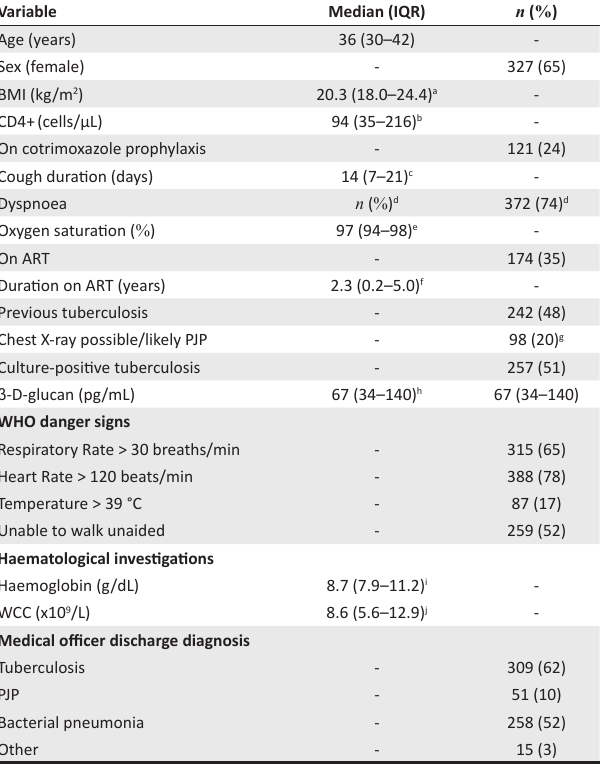
TABLE 1: Baseline characteristics of 500 HIV-infected participants admitted with a cough of any duration and one or more World Health Organization danger signs.